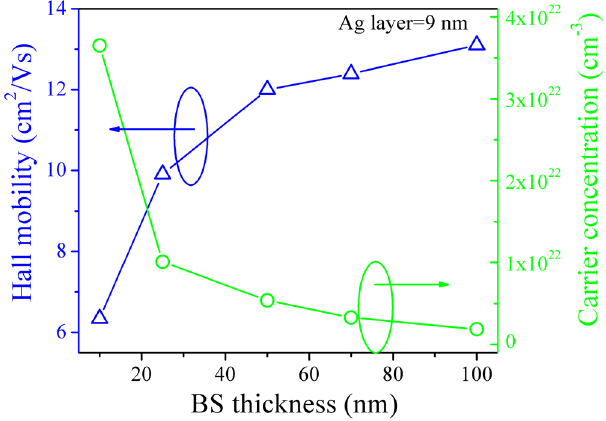
Figure 7. Hall mobility and carrier concentration of the BS/Ag (9 nm)/BS multilayer flexible thin films as a function of BS layers